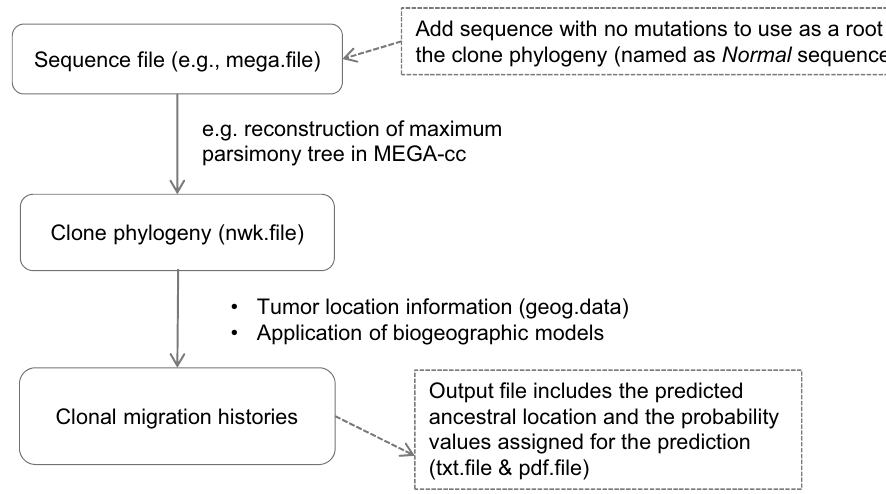
Figure 2. Data analysis pipeline using BioGeoBEARS in R 14 to infer clonal migration histories.